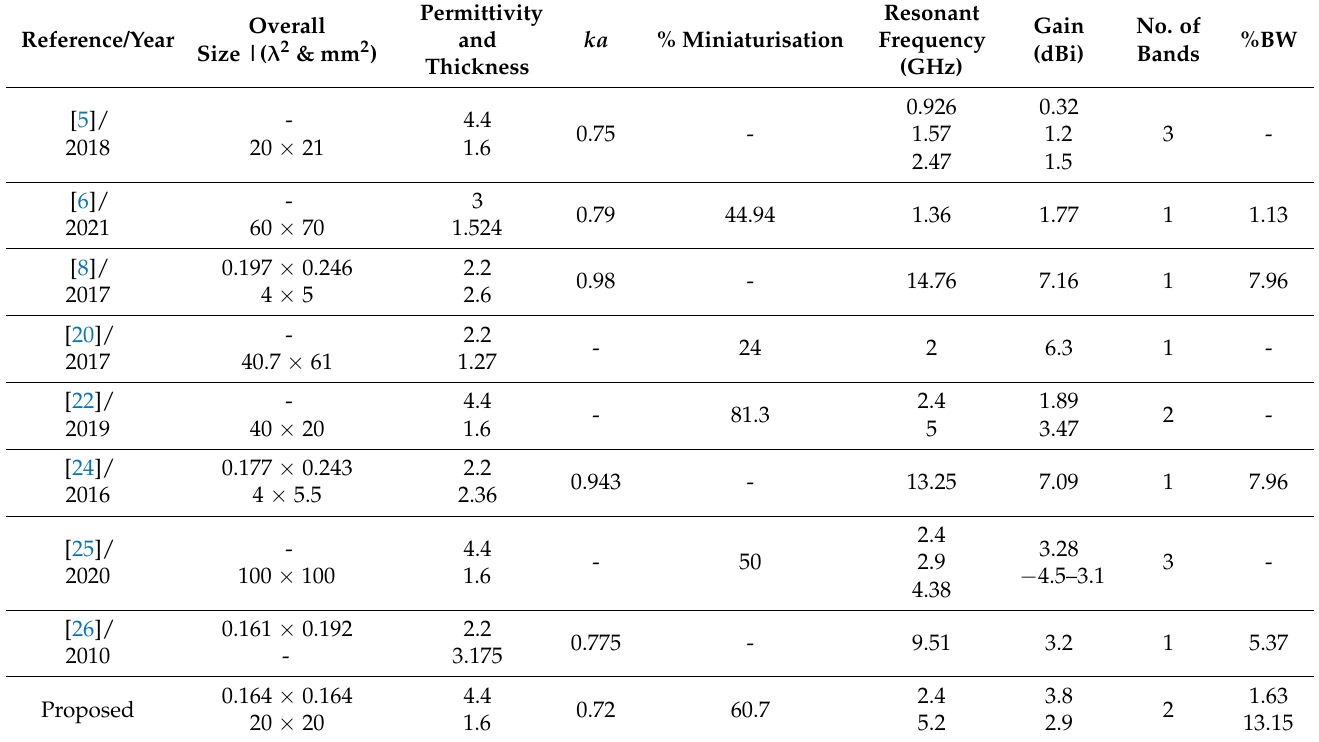
Table 3. Performance comparison of the proposed antenna with the other microstrip patch antennas loaded with